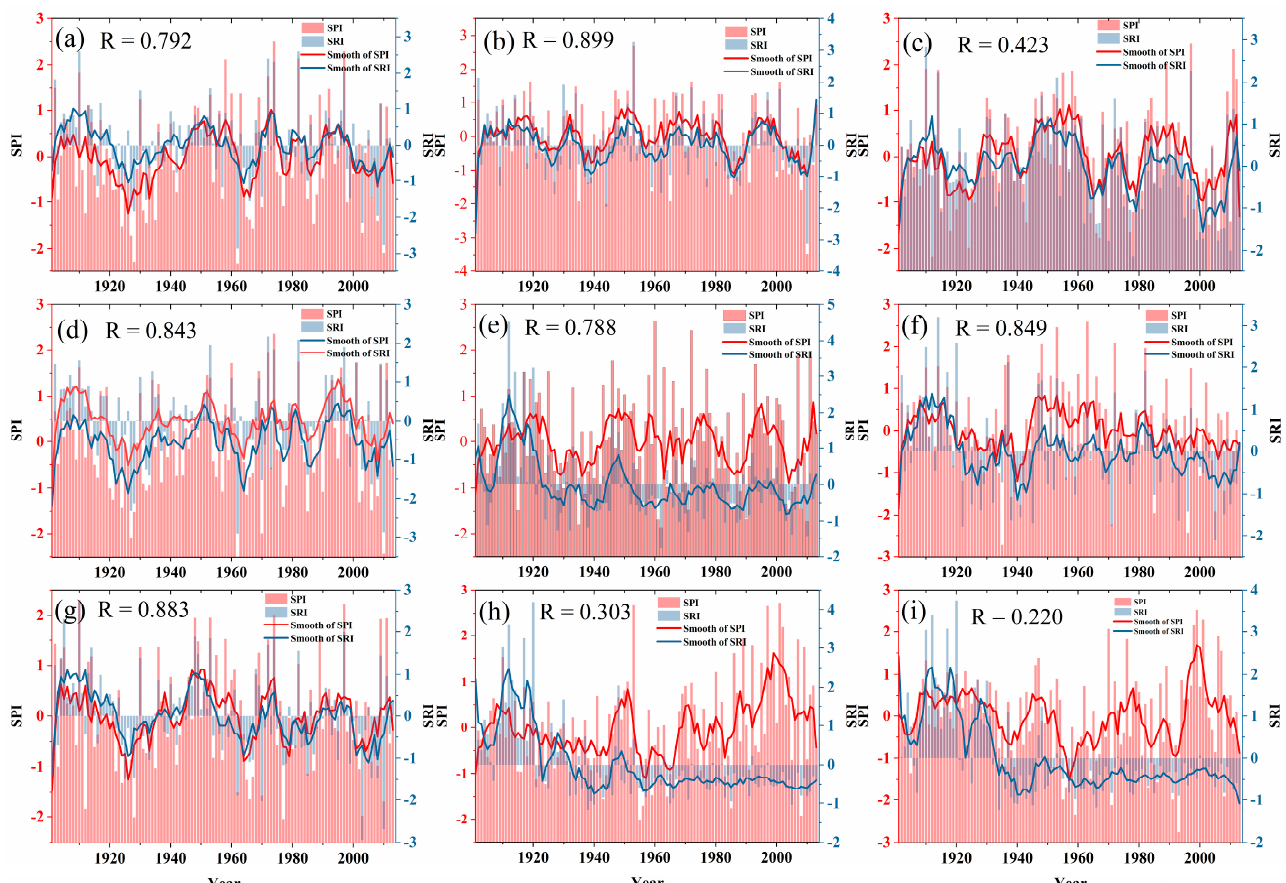
Figure 4. Annual change in the SPI and SRI during 1902–2014 in the SLRB ( a ), HARB ( b ), YRB ( c ), HURB ( d ), YARB ( e ), SEB ( f ), PRB ( g ), SWB ( h ), and CB ( i ) river basins. R represents the correlation coefficient between the SPI and SRI on an annual scale.